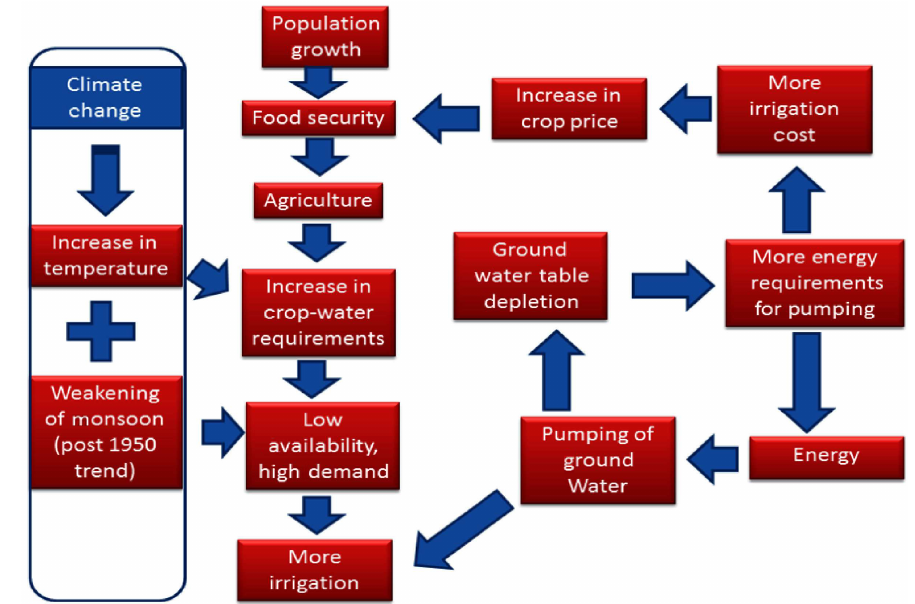
Figure 1. Water–food–energy nexus in India in a changing